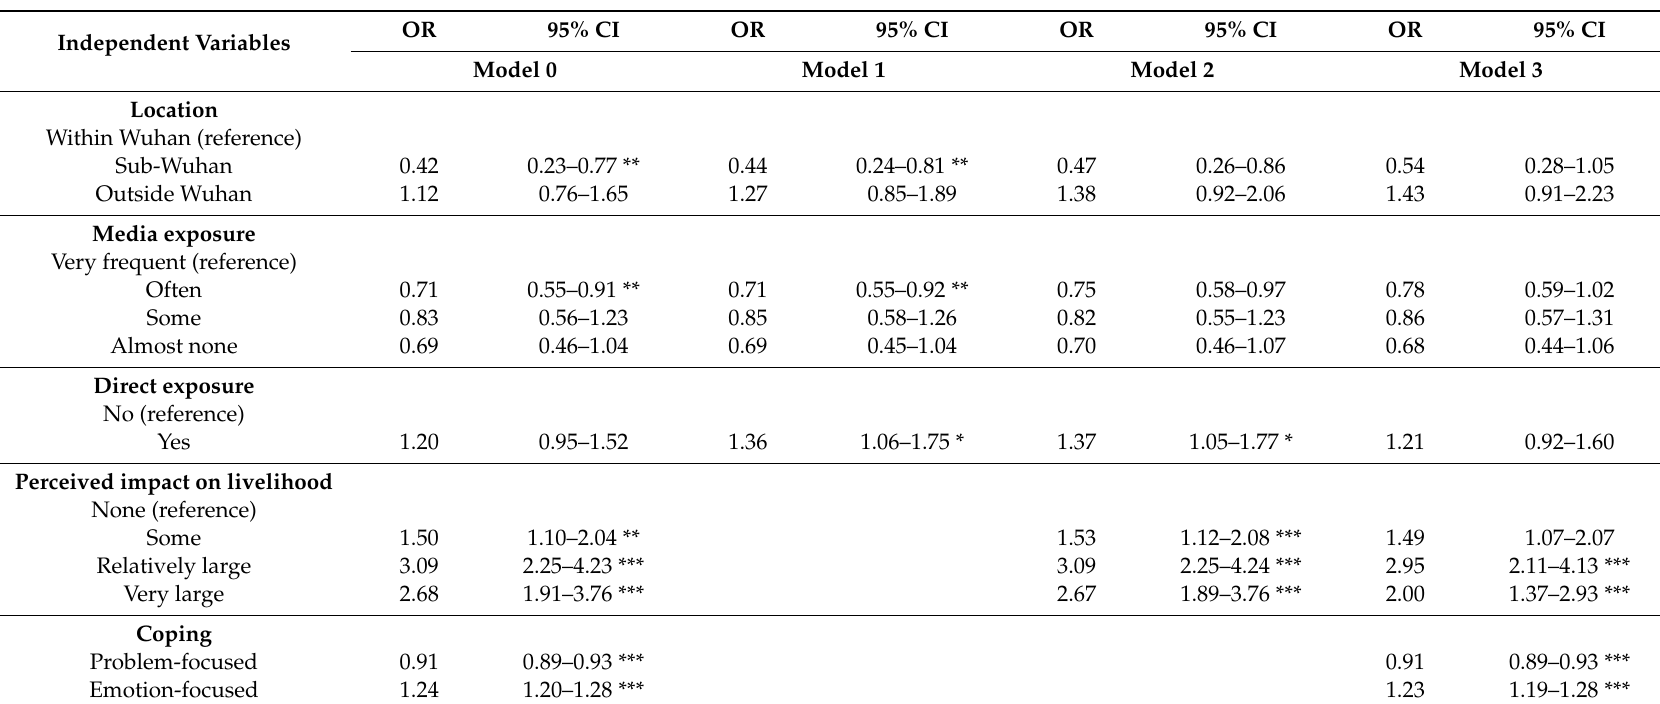
Table 3. Binary logistic regressions with exposure and coping style predicting